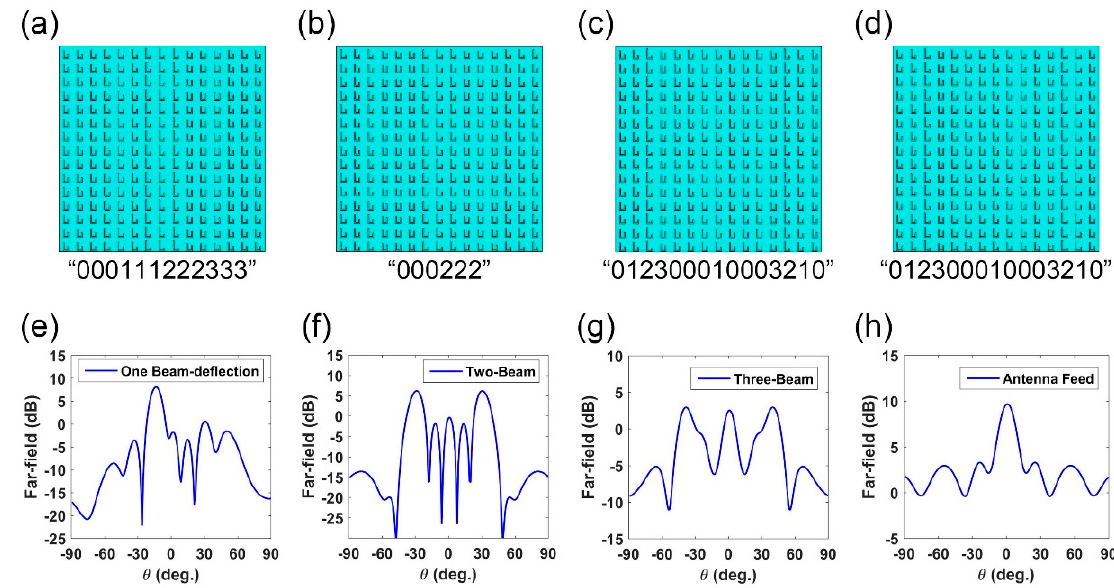
Figure 3. The designed metasurface schemes for different beam manipulation and the related simulation results for far-fields. ( a – d ) The metasurface elements configuration for different surface phase distributions, in which the phase code along x -axis is “0001112223333”, “012300010003210”, “000222” and “012300010003210”, respectively. Please note that the phase distributions are the same in ( b , d ), but their excitations are plane-wave and antenna-source, respectively. The simulated far-field results for the related phase schemes are listed in ( e – h ), where ( e – g ) are excited by plane-wave and ( h ) is excited by antenna.